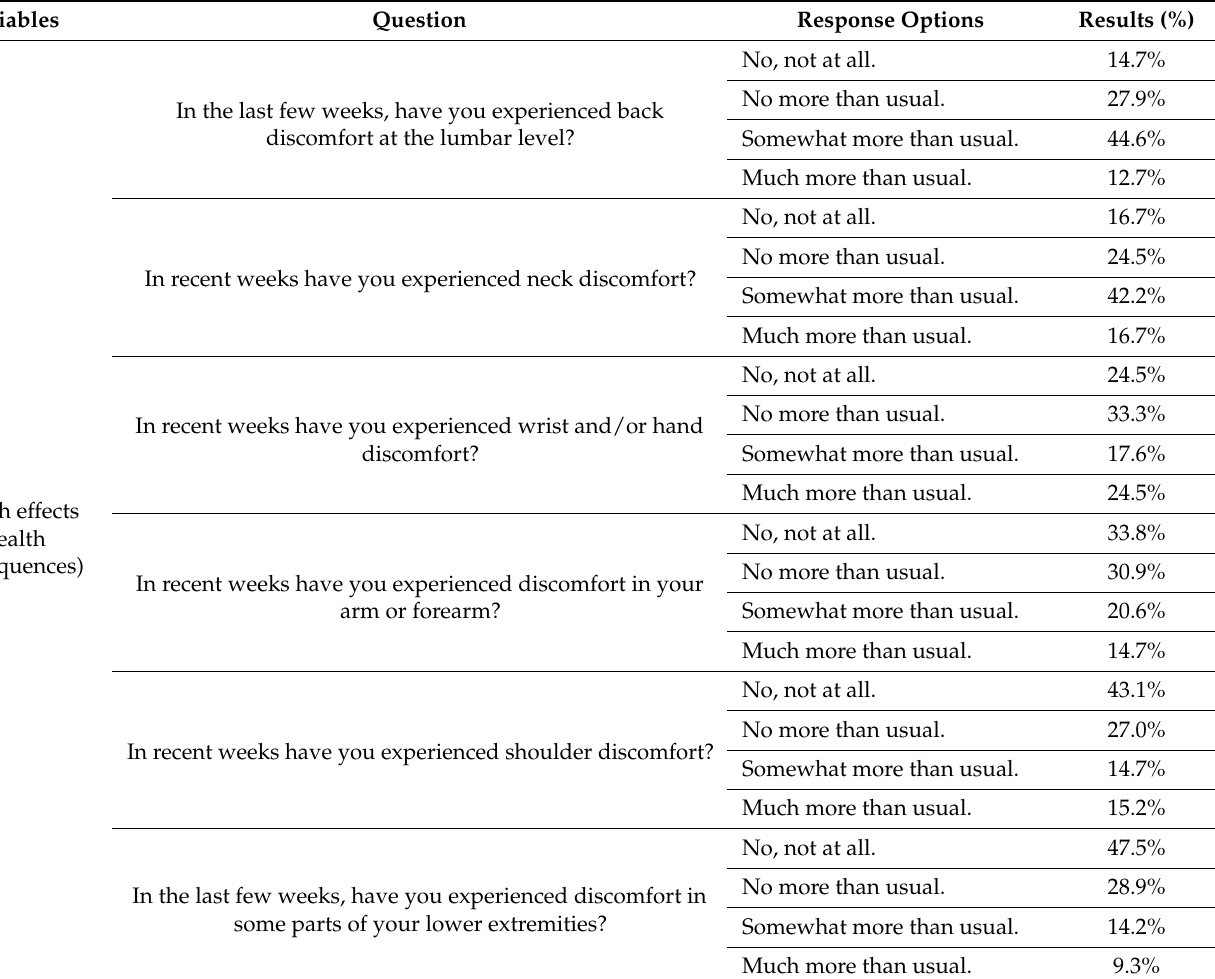
Table A2. List of ailments by telework place with or without the use of an ergonomic chair. More than Usual Pain WITH Ergonomic